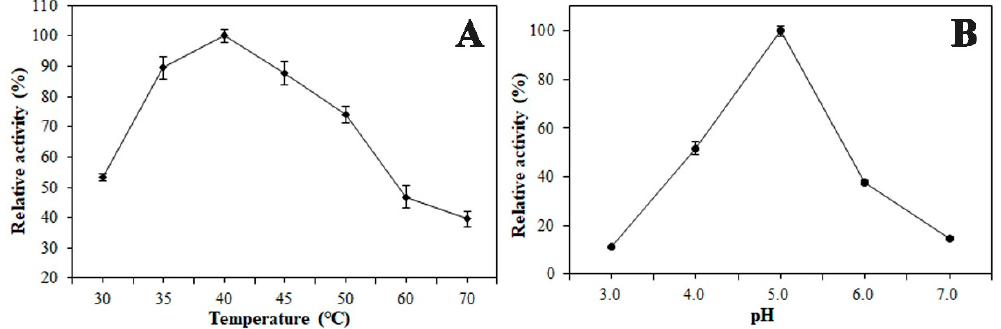
Figure 3. Temperature and pH optima of the B. calycina β -glycosidase / β -xylosidase (BcXyl). ( A ) Temperature optima of BcXyl on pNPGa. ( B ) pH optima of BcXyl on pNPGa. Each point represents the average of three experiments, ± standard error. Table 3. Substrate specificity of BcXyl.